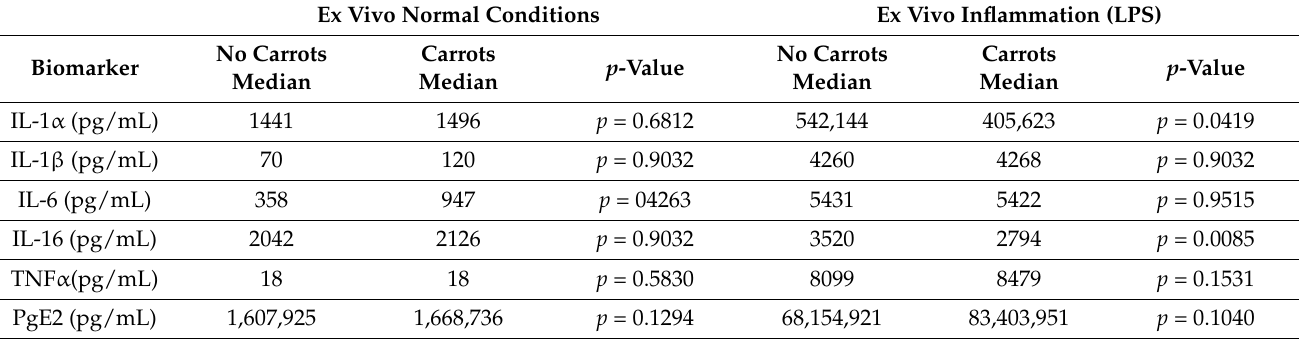
Table 1. Overview of ex vivo results. Interleukin (IL), Tumor Necrosis Factor (TNF), Prostaglandin (PL), Lipopolysacharide